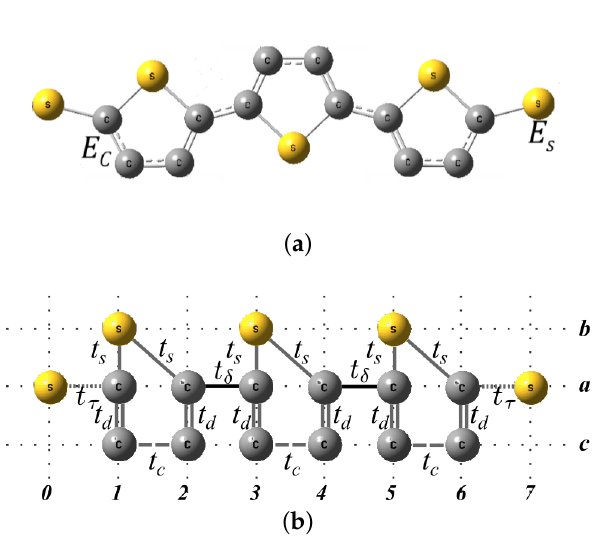
Figure A5. Molecular system ( a ) and geometric model ( b ) with three Thiphene rings without